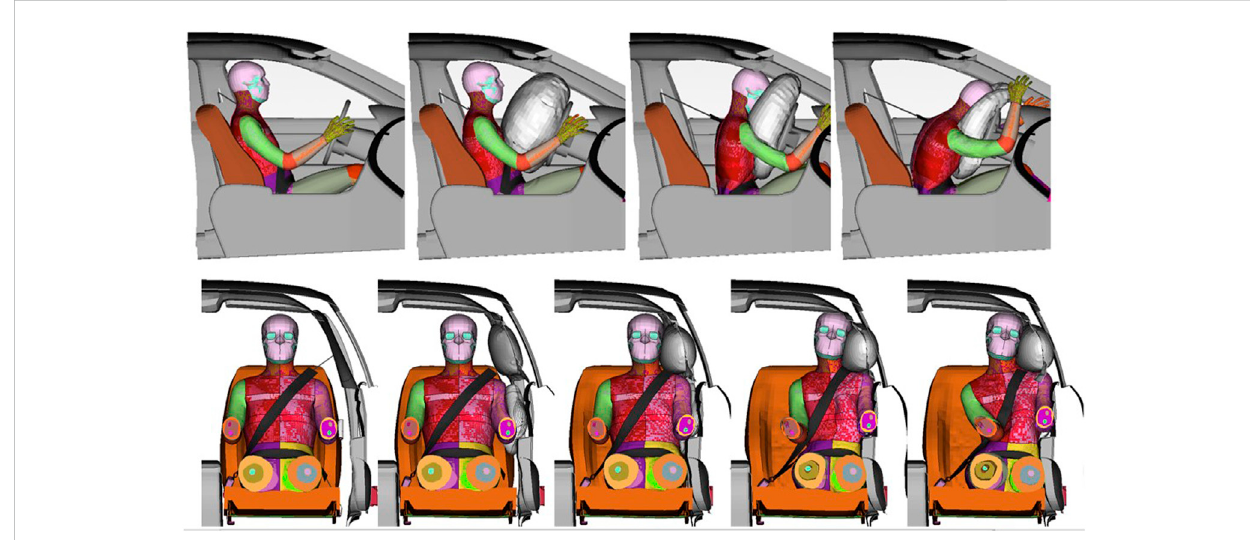
Kinematics of the SHBM in frontal and near-side lateral cut-point evaluations; s = 0 for all parameters. Top: Frontal impact at (left to right) 0, 40, 80, and 120 ms post-impact. Bottom: near-side impact at times 0, 20, 40, 60, and 80 ms post-impact. Arms and legs removed for improved visibility.